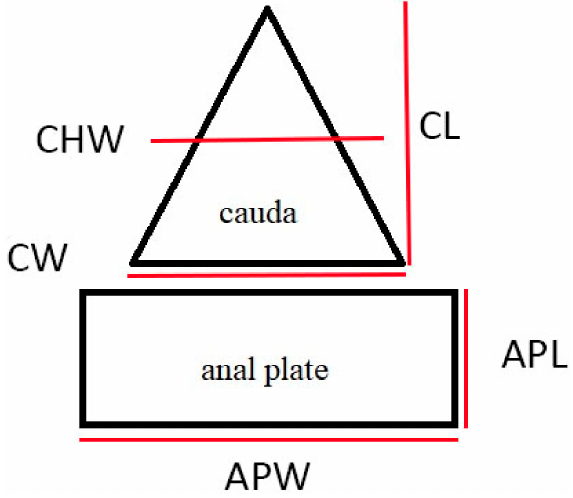
Figure 2. Scheme of measurements of perianal structures applied in this study: CHW—cauda half width; CL—cauda length; CW—cauda width; APW—anal plate width; APL—anal plate length.